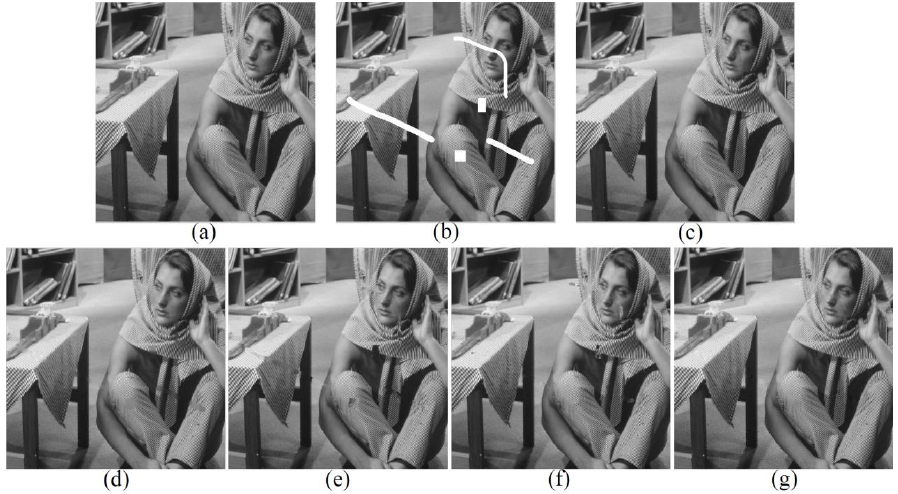
Figure 4. Comparison of Visual Effects on Barbara Image. ( a ) Original Image; ( b ) Corrupted Image; ( c ) Result of Ours; ( d ) Result of MRF; ( e ) Result of Texture Synthesis; ( f ) Result of [24]; ( g ) Result of